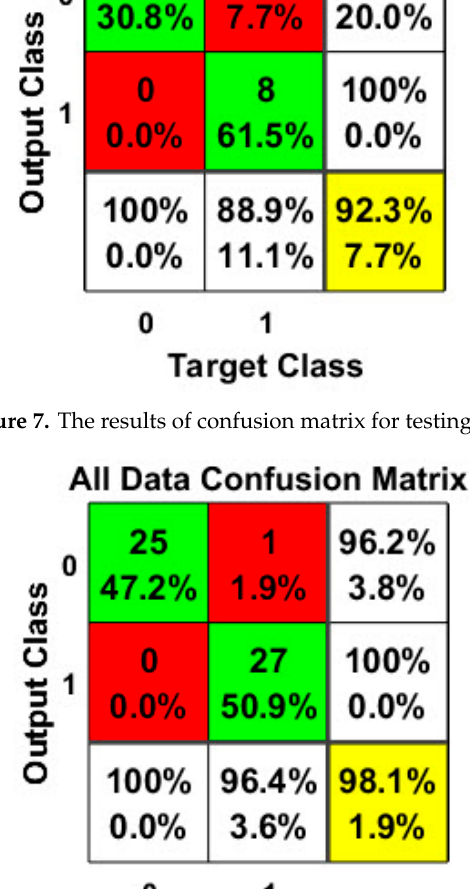
Figure 8. The results of confusion matrix for all data.